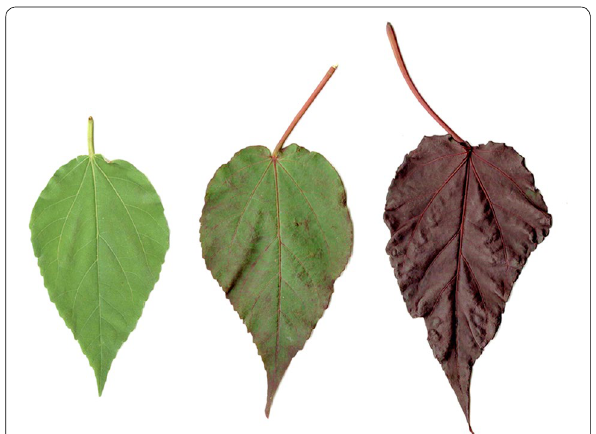
Fig. 1 Leaves of hybrids of Hibiscus moscheutos L. showing foliage color ratings: 1 (left), 3 (middle), and 5